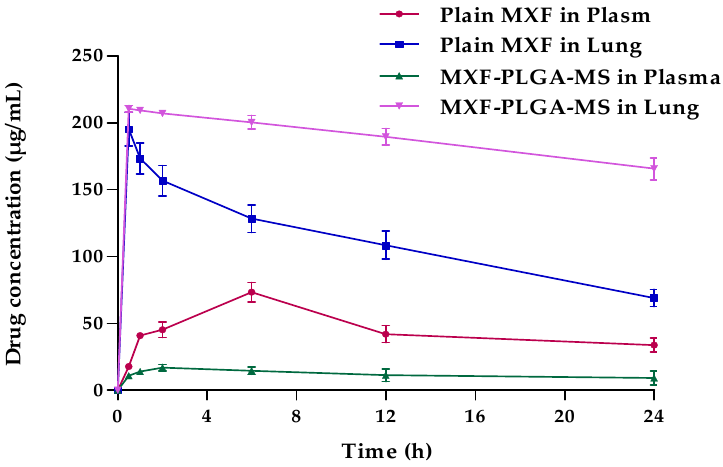
Figure 6. Mean concentration-time profile after inhalation of plain drug and MXF-PLGA-MS in plasma and lung.